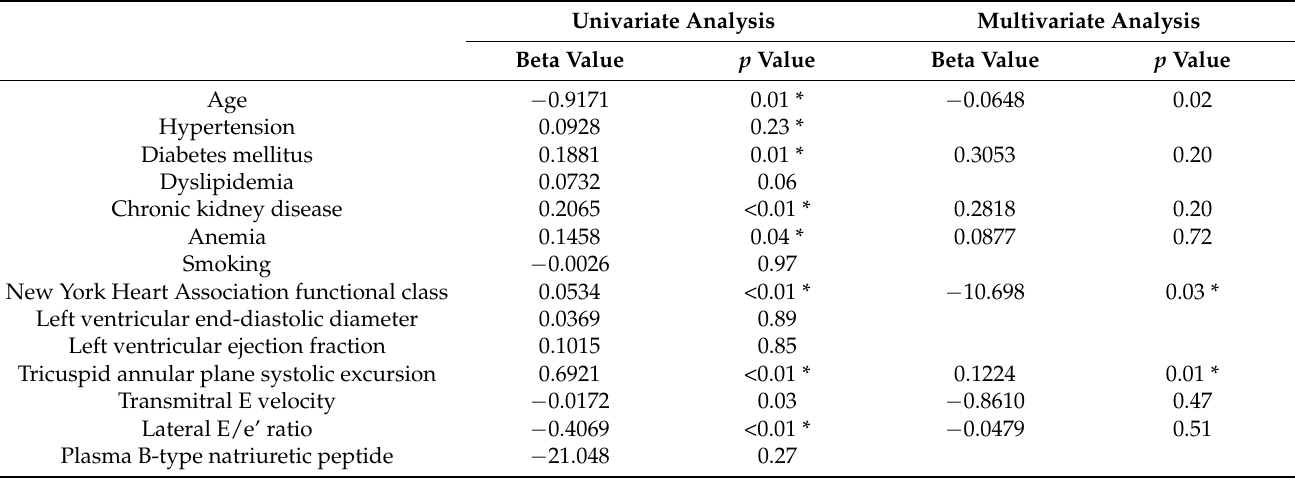
Figure 2. AT ( A ) and PVO2 ( B ) levels stratified by the tertiled TAPSE. * p < 0.05 compared with the lowest title by post-hoc Tukey’s test. Table 3. Association between AT and clinical parameters including